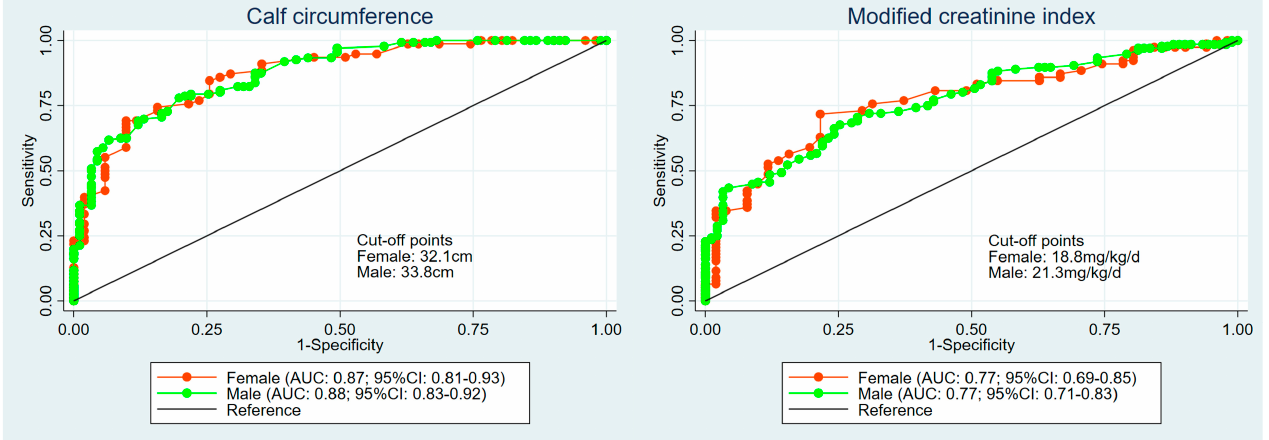
Figure 3. ROC curves of the simplified discriminant parameters against sarcopenia, created based on a reference from Kakita et al.